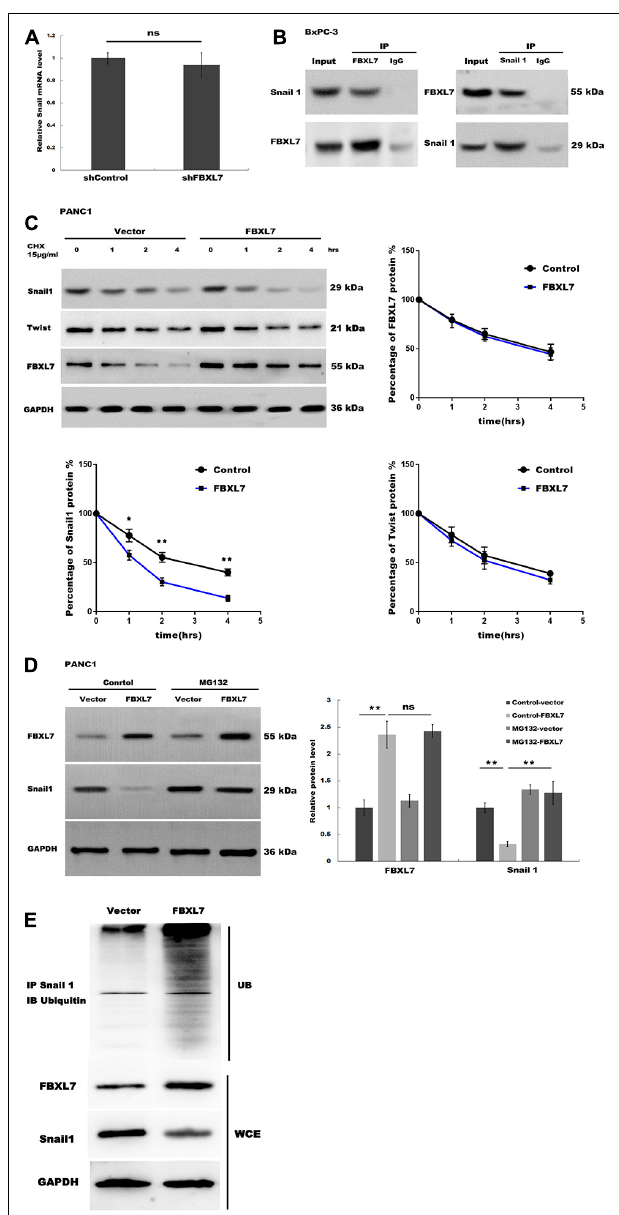
FIGURE 5 | FBXL7 induces Snail 1 ubiquitination and proteasomal degradation. (A) The expression of Snail1 mRNA was detected in BxPC-3 cells with or without FBXL7 knockdown by RT-qPCR analysis. (B) The relationship between FBXL7 and Snail1 was detected by co-IP assay using anti-FBXL7 or anti-Snail1 antibody in BxPC-3 cells. (C) The expression of Snail1, Twist,and FBXL7 was detected in PANC1 cells overexpressed with FBXL7 at 0, 1, 2, and 4 h by cycloheximide chase assay. Data represent means ± SD of three independent experiments with significance determined by two-tailed Student’s t -test * P < 0.05, ** P < 0.01. (D) The expression of SNAIL1 was detected in PANC1 cells transduced with or without FBXL and applied MG132 by Western blot. (E) FBXL7 increases the ubiquitination of Snail1. Control and FBXL7 infected cell lysates were immunoprecipitated with anti-Snail1 antibody. The IP was then analyzed by immunoblotting with anti-ubiquitin antibody. WCE = whole cell extract. Data represent means ± SD of three independent experiments with significance determined by one-way ANOVA followed by the Scheffé test. ** P <